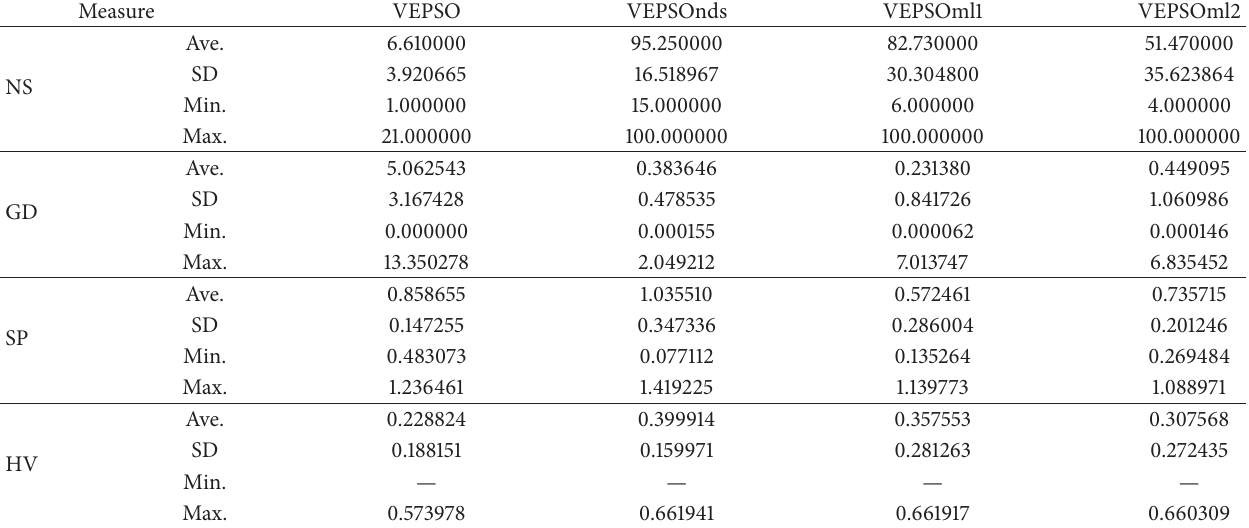
Table 5: Algorithm performance tested on ZDT4